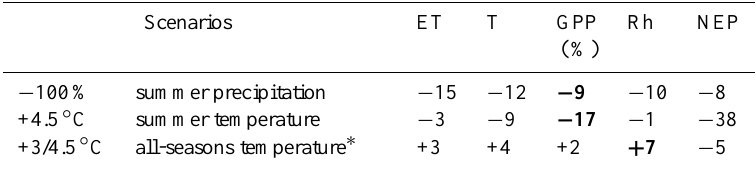
The annual treatment effect is given in brackets. Table 5. Overview of the effects of climate scenarios on ecosystem fluxes in comparison to the 2010/11 conditions. The scenarios are: no summer precipitation, increased summer temperature and warming across all seasons (see Fig. 5). The larger effect between gross primary productivity (GPP) and heterotrophic respiration (Rh) is depicted in bold. Note that GPP is more affected by increases in summer temperature than by reductions in summer precipitation, confirming our first hypothesis. Considering our second hypothesis, we find a larger increase in Rh than GPP under the all-seasons warming scenario, while the change in summer precipitation affected Rh less than